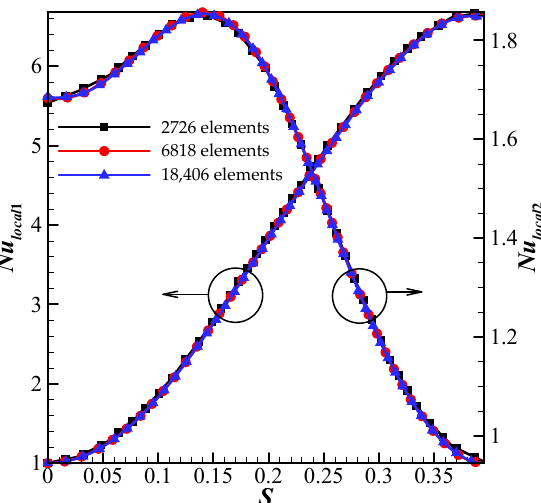
Figure 2. Mesh independence study.